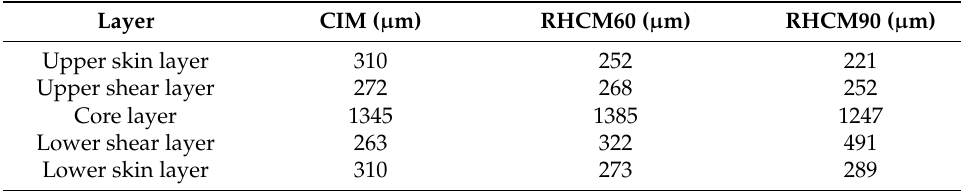
Figure 5. Polarized micrographs of parts under different processes. Table 1. The thickness of each layer under different